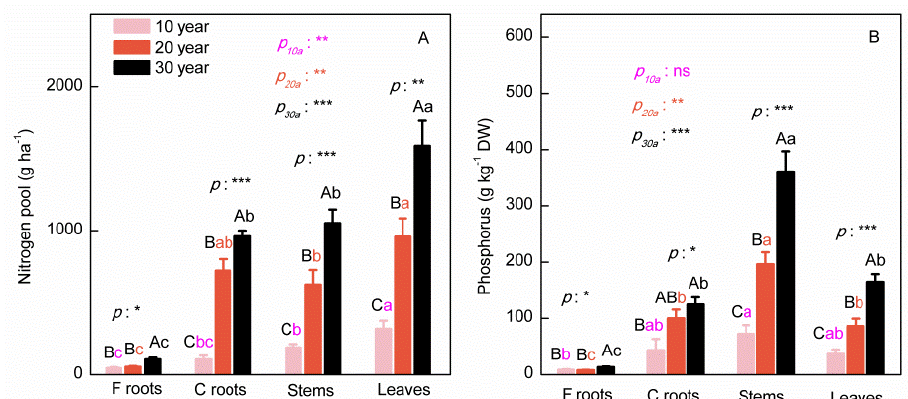
Figure 4. The N ( A ) and P ( B ) pools (dry weight, kg ha − 1 ) of all Chinese fir. The uppercase letters on the bars indicate significant difference between different aged trees of the same organs, while the lowercase letters indicate significant difference among organs in trees with same age. *, **, ***, and ns were indicated p < 0.05, p < 0.01, p < 0.001, and no significance, respectively.